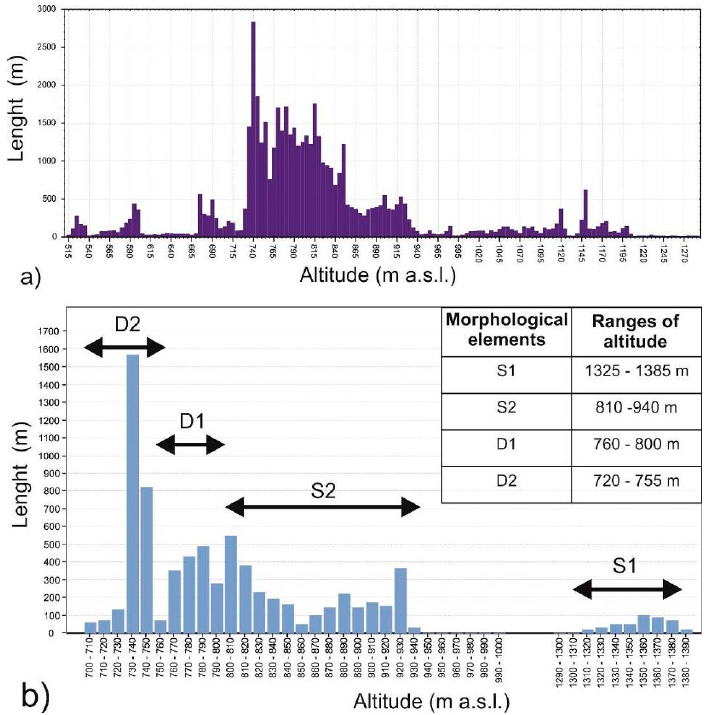
Figure 7. Histogram representing the frequency distribution of altitudes of the whole path ( a ) and only for the tracts of the path that intercept low-angle erosional and depositional morphological surfaces ( b ).